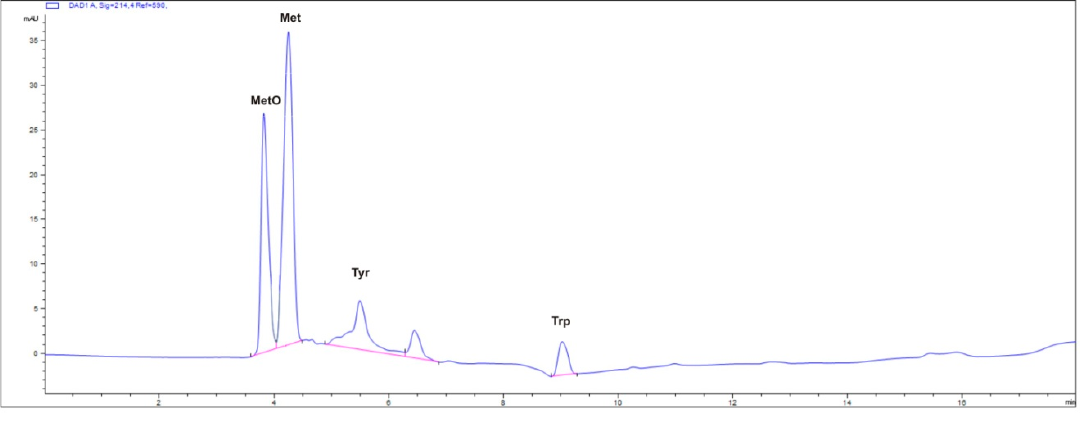
Figure 2. Proportion of Met oxidized to methionine sulfoxide (MetO) in proteins of desiccated Norway maple and dehydrated sycamore seeds. A representative chromatogram indicating peaks recognized at 214 nm is shown. Standards of Met, MetO, tyrosine (Tyr) and tryptophan (Trp) were used for the calibration curves. The MetO ratio was calculated in relation to the total pool of Met. The data are the means of three independent replicates ± the STDs. The same letters indicate groups that are not significantly different according to Tukey’s test. 3.3. MsrB1 and MsrB2 Content in Drying Acer Seeds Immunodetection of the two B-type isoforms of Msrs, MsrB1 and MsrB2, was performed during desiccation of Acer seeds. The MsrB1 protein was not detectable in Norway maple seeds. In sycamore, MsBr1 was present from 60% to 30% WC, with the highest amount detected in the embryonic axes dehydrated to 50% WC (Figure 3A). MsrB1 was found in sycamore cotyledons at all stages of